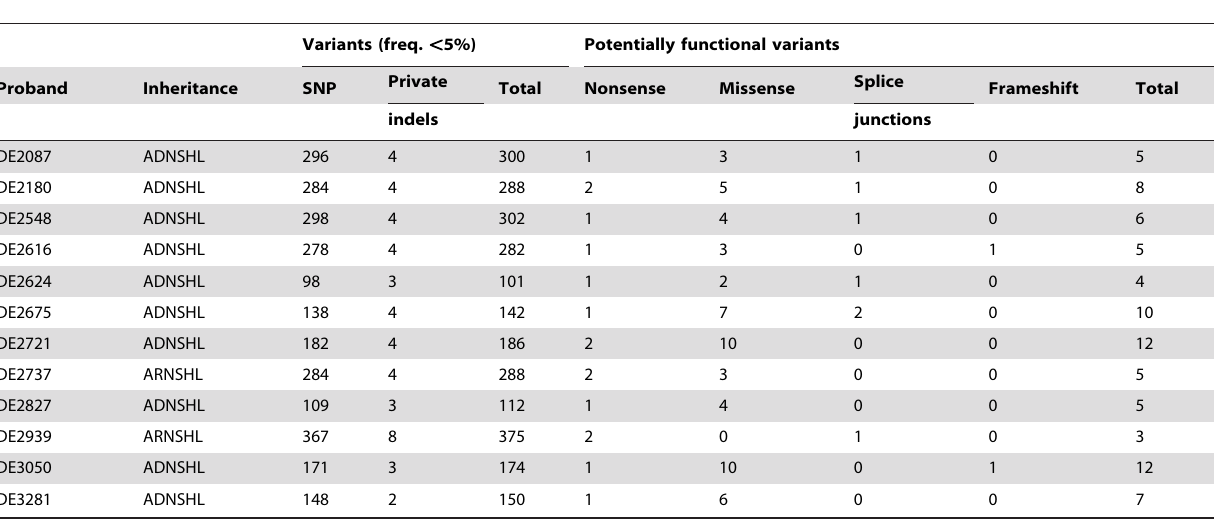
Table 1. Number of Variants Detected in the Probands of the 12